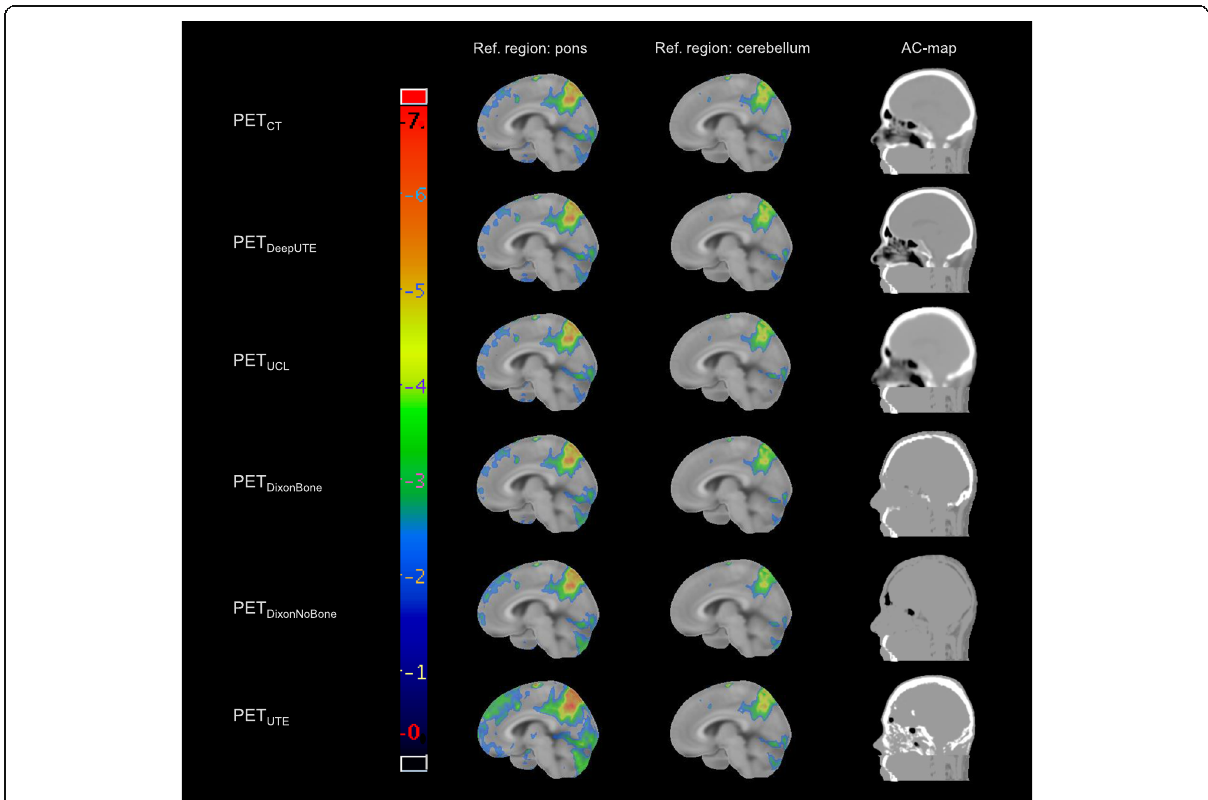
Fig. 4 Examples of z-score maps for one patient (number 16) for the included AC methods, with pons and cerebellum as reference regions, and the corresponding attenuation